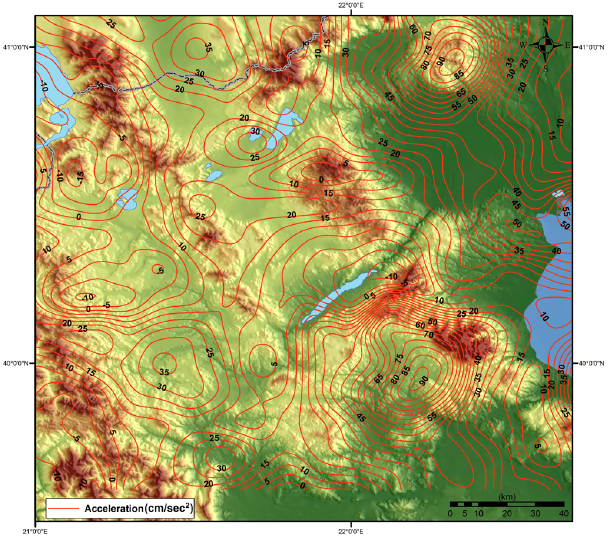
Fig. 9. Difference of Peak Ground Acceleration (cms − 2 ) values with probability 90% of not being exceeded in 50yr (Return Period = 475yr) between the periods: PGA 1900 − 1994 – PGA 1900 − 1973